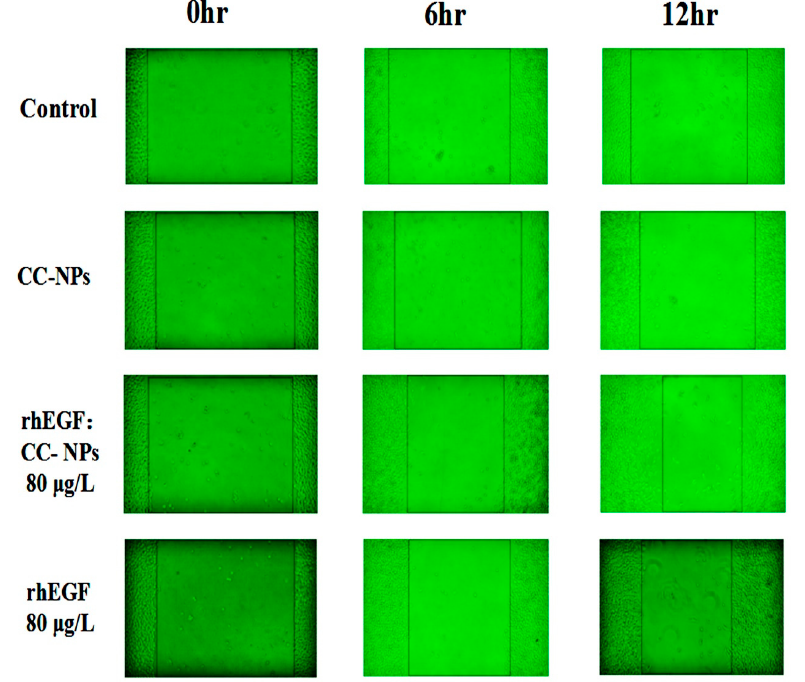
Figure 7. In vitro migration test.